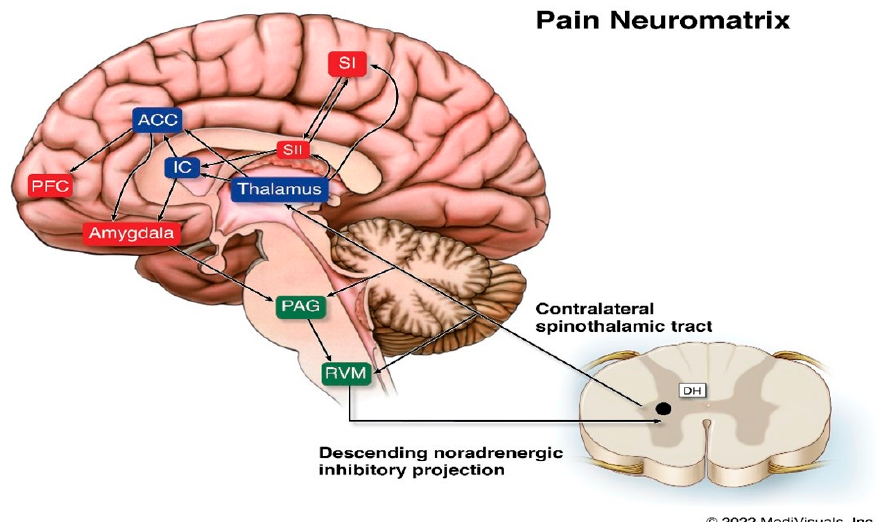
Figure 1. Legend: Schematic diagram of the pain neuromatrix involving cortical and subcortical structures. ACC, anterior cingulate cortex; DH, dorsal horn; IC, insular cortex; PAG, periaqueductal gray; PFC, prefrontal cortex; RVM, rostral ventral medulla; SI, primary somatosensory cortex; SII, secondary somatosensory cortex.